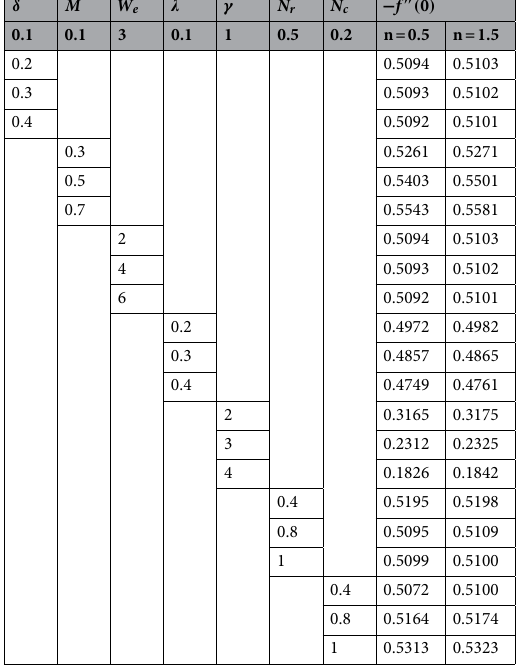
Table 3. Numerical analysis of skin friction coefficient